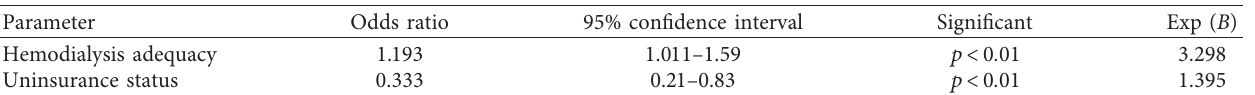
Table 5: Effect of the dependent variables; hemodialysis adequacy; and insurance status on the dependent variable death-censured graft survival as obtained by Cox’s proportional hazards